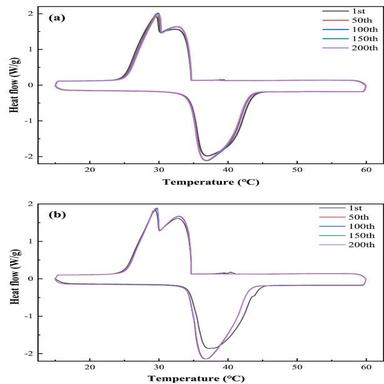
DSC curves of (a) MicroEPCM-4%BN; (b) MicroEPCM-6%SiC.